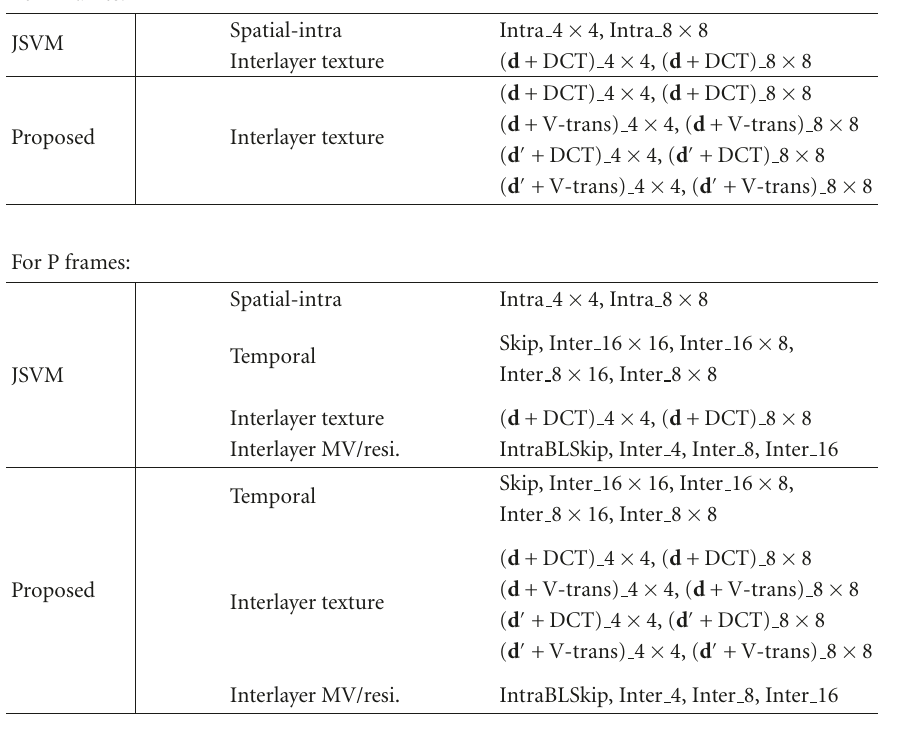
Table 2: Definition of macroblock modes for I and P frames in JSVM and proposed encoding